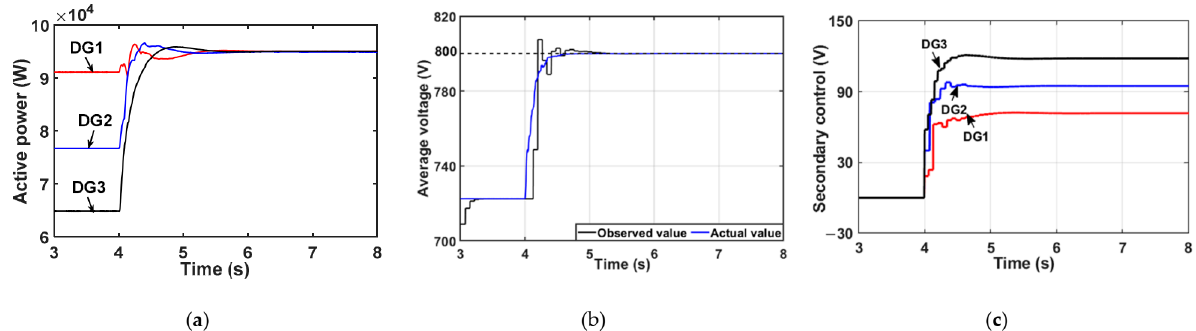
Figure 10. Simulation results for asynchronous sampled system with proposed algorithm. ( a ) Active powers. ( b ) Average voltage. ( c ) Secondary control